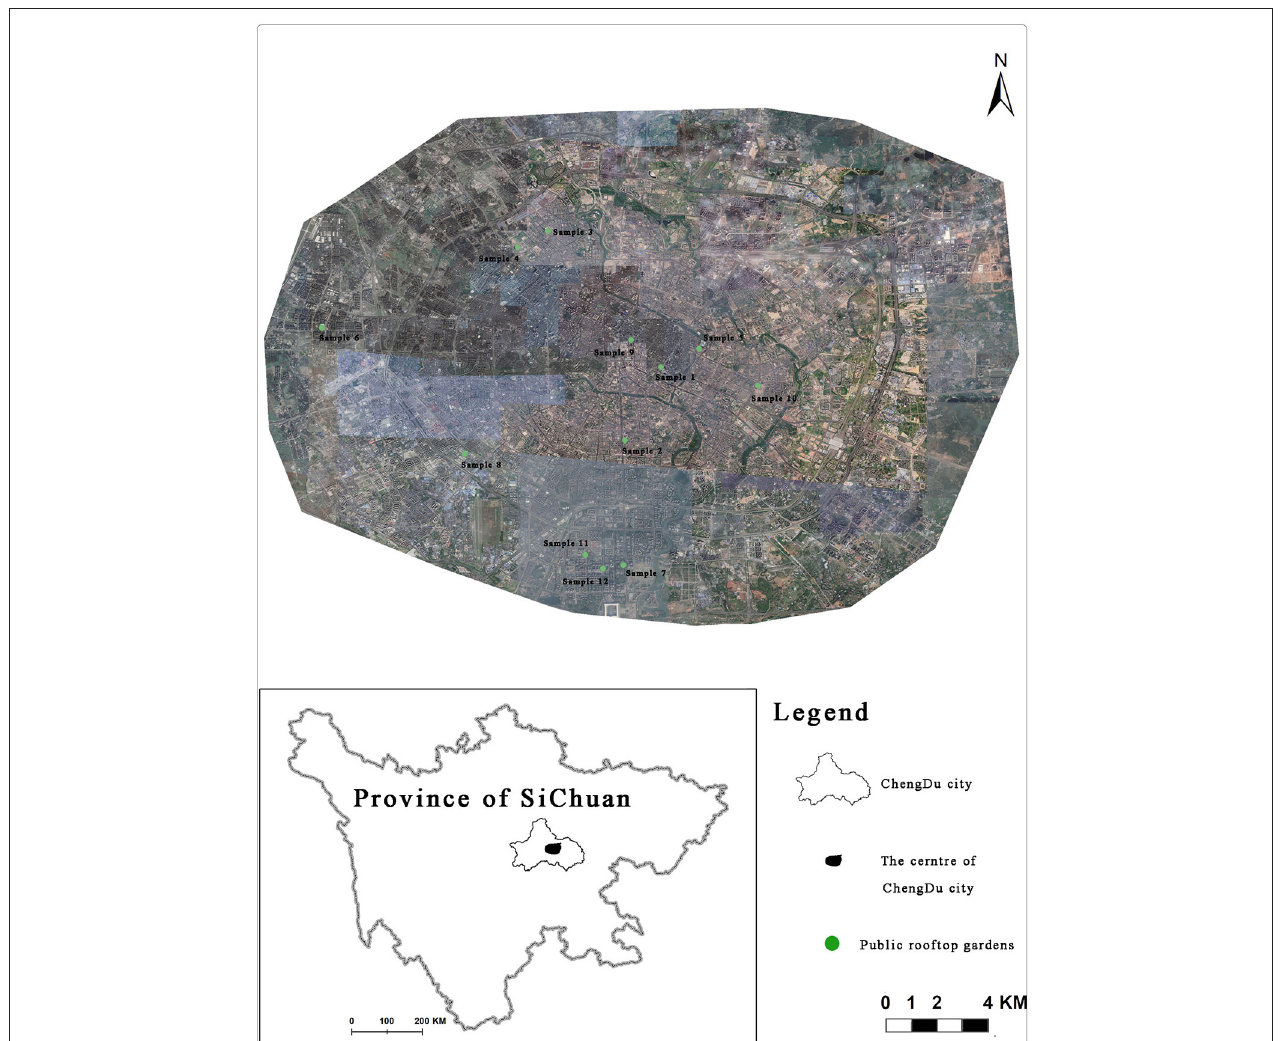
FIGURE 1 | The spatial distribution of each public rooftop garden in center of ChengDu city.